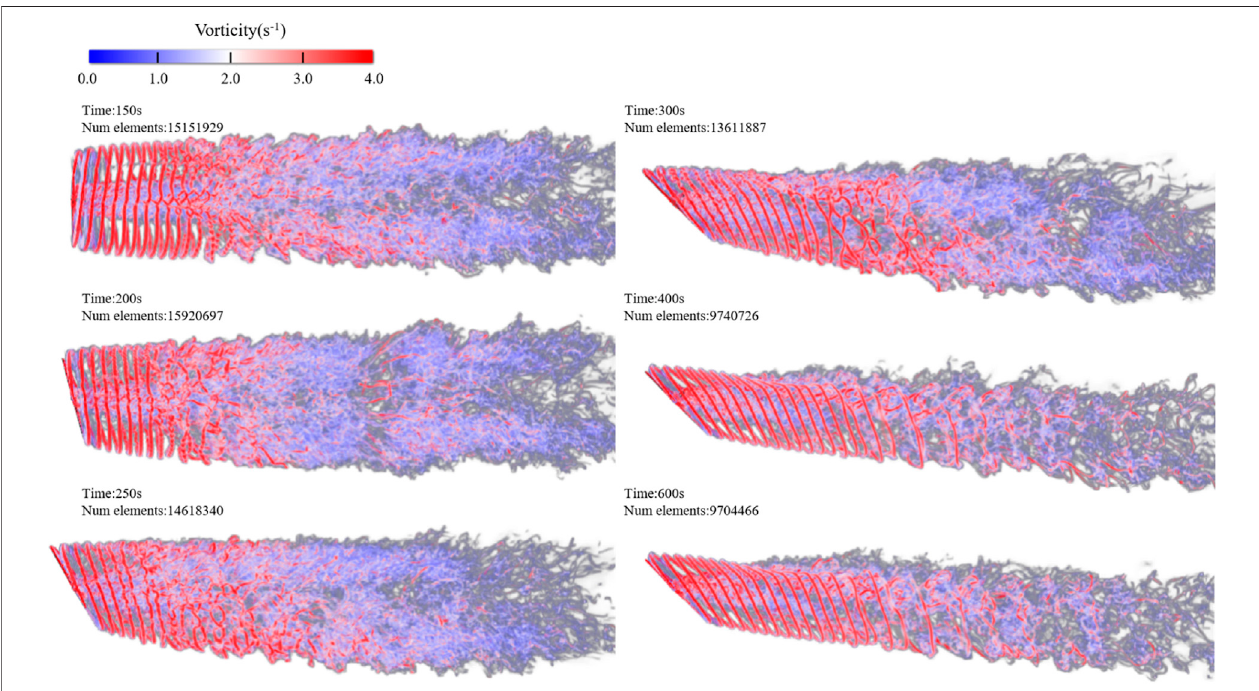
FIGURE 11 | Instantaneous vorticity contour of the horizontal section at the hub height under the slow dynamic yaw.